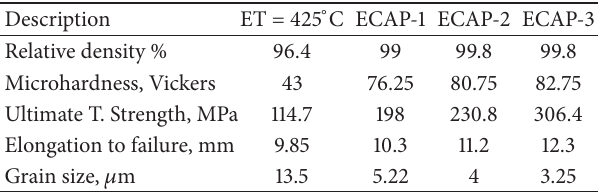
Table 3: Effect of ECAP process on the Solid Sate